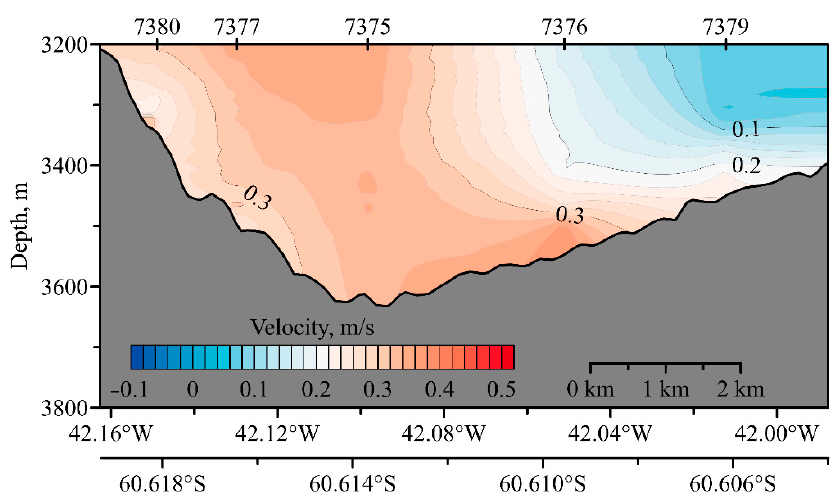
Figure 6. Longitudinal velocity component (normal to the section) across the Orkney